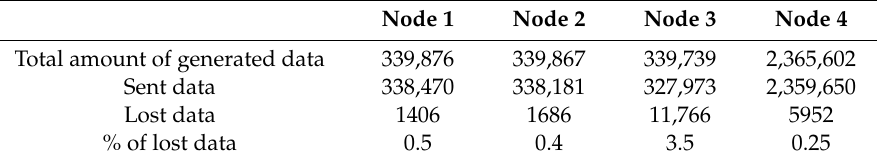
Table 7. Records of generated data.